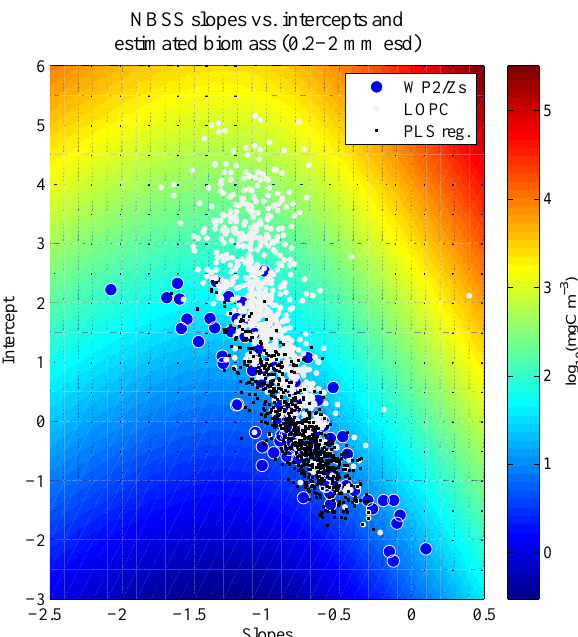
Figure 6. Scatter graph of the relations between slopes and inter- cepts computed from NBSS estimated by the WP2/Zs (blue circles), the LOPC (grey circles) and by the PLS (partial least square) re- gression (black square). The color map corresponds to the biomass computed as the integration of the log-linear NBSS in the range 0.2–2mm ESD.